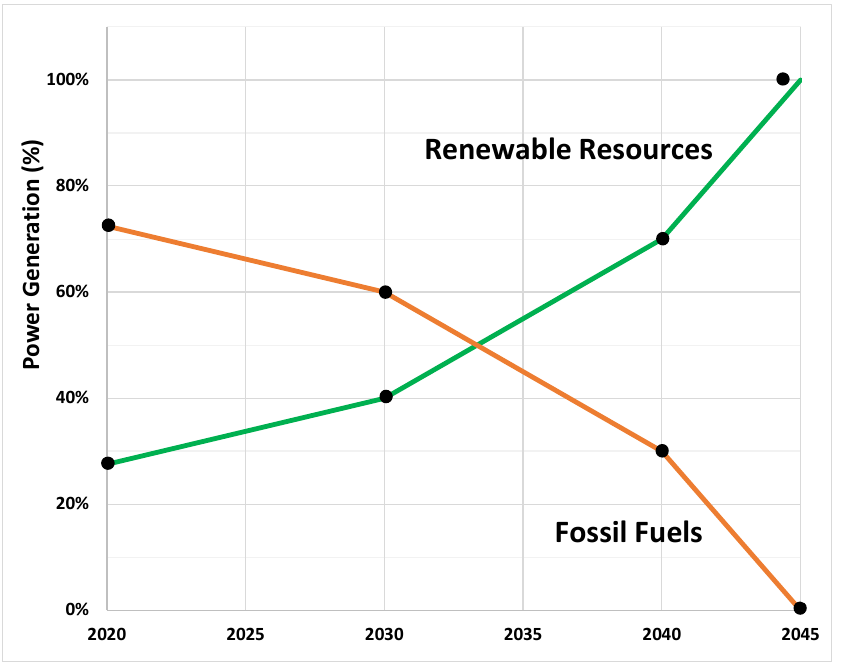
Figure 6. Renewable power generation ( green ) based on the State’s Renewable Portfolio Standard (RPS) to replace fossil fuel ( orange ) through 2045. (Black markers show the data points used to generate the curve.)